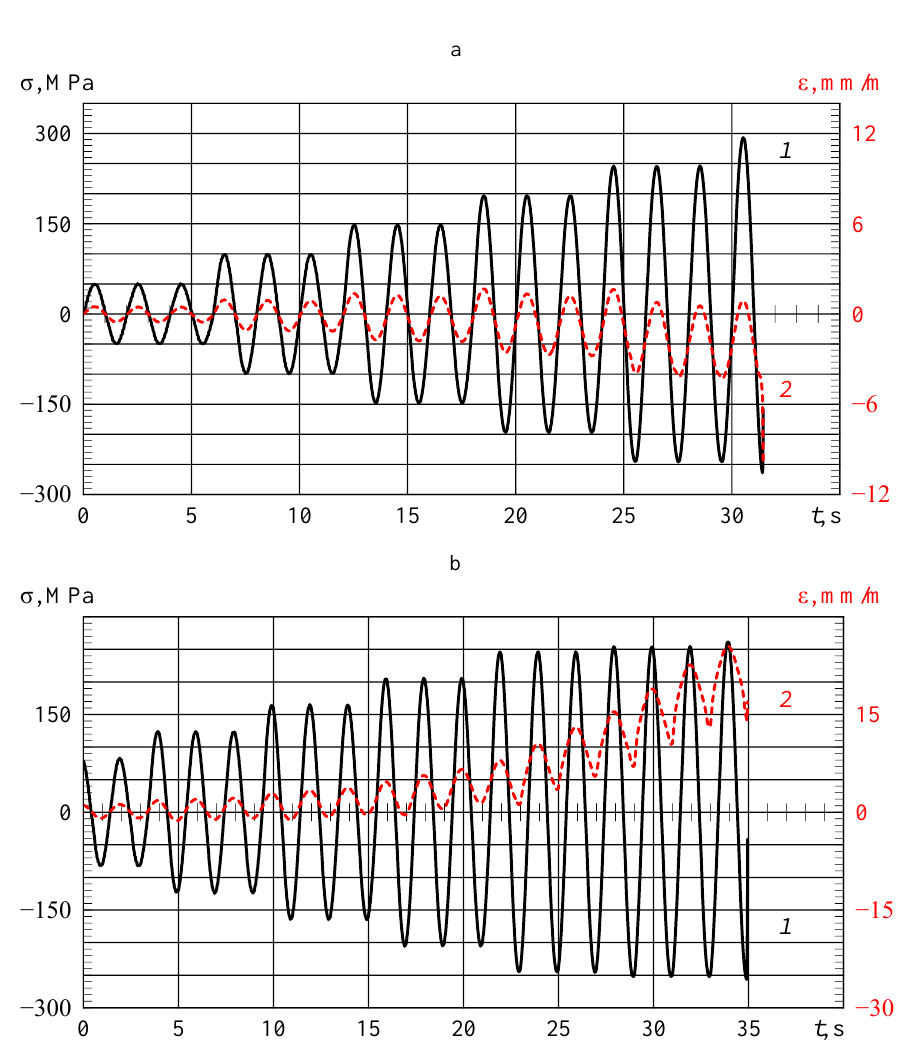
Fig. 1. Loading of specimen 1 (a) and specimen 2 (b): 1 – change in stress over time, 2 – change in longitudinal